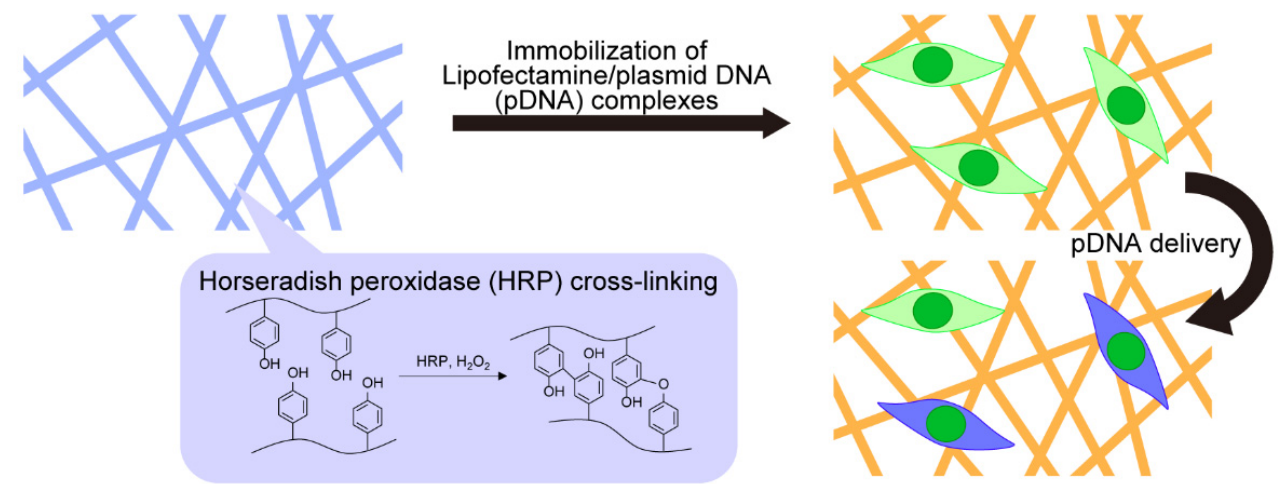
Figure 1. Schematic illustration of insolubilization of nanofibers through horseradish peroxidase (HRP)-mediated cross-linking and immobilization of Lipofectamine/plasmid DNA (pDNA) com- plexes on the nanofibers with subsequent pDNA delivery to cells cultured on the nanofibers.